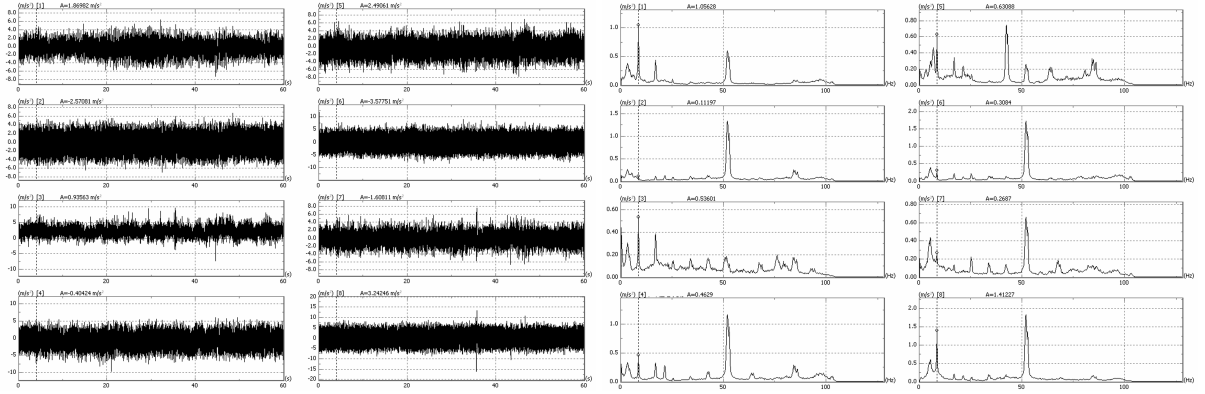
Fig. 11 Waveform and spectrum of each measuring point at a speed of 100